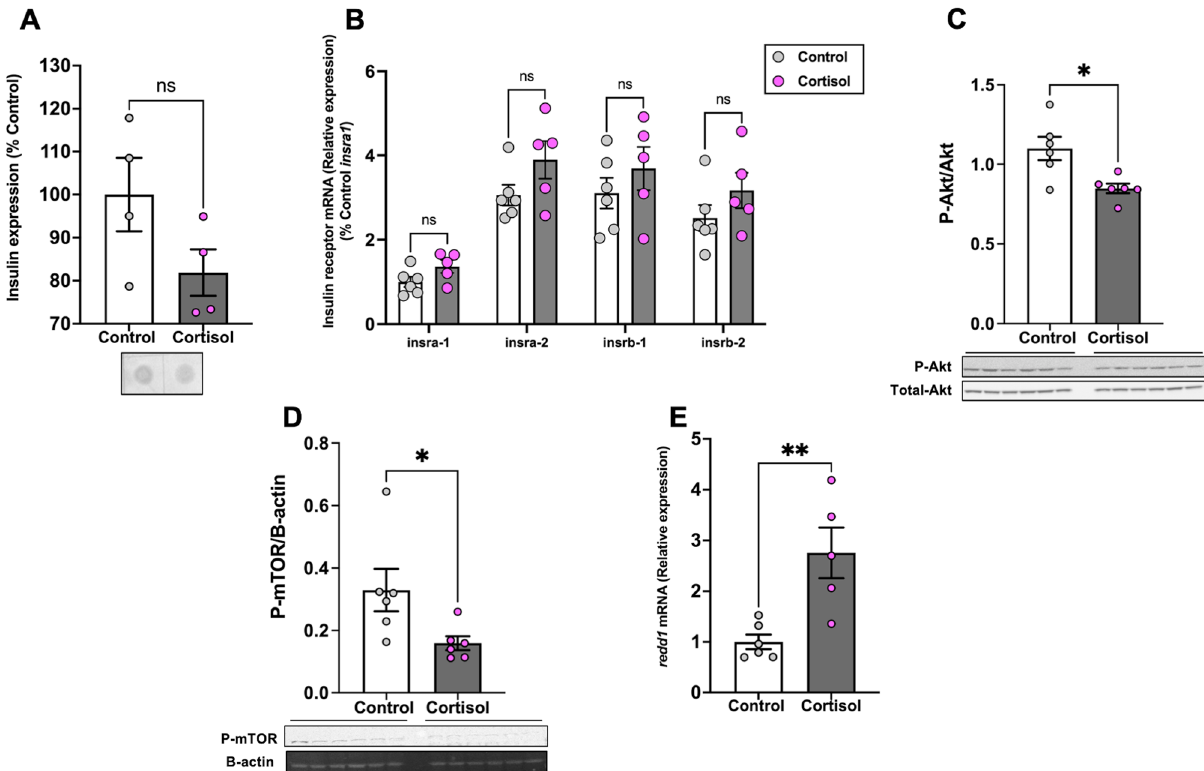
Figure 6. Cortisol affects brain Akt and mTOR phosphorylation. ( A ) Cortisol treatment did not change whole-body insulin expression levels. ( B ) We observed no changes in the transcript levels of the insulin receptor genes in the brain after cortisol treatment. ( C ) The ratio of phosphorylated to total Akt (M.W.:60 kDa) in the brain was significantly lower in the cortisol-treated fish when compared to the control. ( D ) The phosphorylation of mTOR (M.W.:289 kDa) was also significantly lower after cortisol treatment. E. redd1 mRNA levels significantly increased in the brain of the cortisol treated group compared to the control. Values are means ± SEM (Whole-body insulin n = 4; Protein expression n = 6; Transcript abundance n = 5–6). ns—not significant; *( P < 0.05); **( P < Cortisol affects brain Akt and mTOR phosphorylation. To test if cortisol affects Akt-mTOR path- way, we measured the whole-body expression of insulin, as well as their receptors and key signalling markers, including Akt and mTOR phosphorylation in the brain of zebrafish. Cortisol did not significantly affect whole- body insulin expression compared to the control group (Fig. 6A; P = 0.122). Also, cortisol did not significantly affect the transcript abundance of the insulin receptors, including insra-1 ( P = 0.088), insra-2 ( P = 0.118), insrb-1 ( P = 0.367) and insrb-2 ( P = 0.232) in the brain of zebrafish compared to the control group (Fig. 6B). However, cortisol exposure significantly reduced the ratio of phosphorylated to total Akt in the brain of zebrafish com- pared to the control group (Fig. 6C; P = 0.010). Additionally, the cortisol-treated fish had significantly lower expression of the phospho-mTOR compared to the control group (Fig. 6D; P = 0.039). To test if elevated cortisol levels affect brain protein breakdown, we measured the transcript abundance of redd1 , an inhibitor of mTOR signalling and a marker of proteolysis 34 . Cortisol exposure significantly increased the transcript abundance of redd1 in the brain of zebrafish compared to the control fish (Fig. 6E; P = 0.003). Lack of GR suppresses food intake. To test if cortisol-GR activation influenced food intake, WT and MRKO fish were subjected to feeding trials before and after exposure to exogenous cortisol. The food intake did not significantly change between the WT and MRKO fish before cortisol treatment (Fig. 7A). However, after cor- tisol exposure, both WT and MRKO mutants had a significant reduction in food intake compared to the control (untreated group) (Fig. 7A; P < 0.0001), suggesting that cortisol-GR activation suppresses appetite. To further confirm if the lack of GR also suppressed feeding, we carried out feeding trials with the GRKO fish 8 . Fish lack- ing GR were hypercortisolemic (Supplemental: Fig. S4A; P = 0.04), while the blood glucose levels (Supplemen- tal: Fig. S4B; P = 0.162) and the liver pck1 transcript abundance remained unchanged (Supplemental: Fig. S4C; P = 0.093) between the two genotypes. There was a significant reduction in food consumption in the fish lacking GR compared to the wildtype (Fig. 7B; P = 0.040). There was no significant change in the mRNA transcript levels of npy (Supplemental: Fig. S5A; P = 0.062), crh (Supplemental: Fig. S5B; P = 0.074), pomca (Supplemental: Fig. S5C; P = 0.995), mc3r (Supplemental: Fig. S5D; P = 0.094), mc4r (Supplemental: Fig. S5E; P = 0.346). How- ever, the GRKO fish had decreased lepa expression compared to the WT (Supplemental: Fig. S5F; P = 0.044).